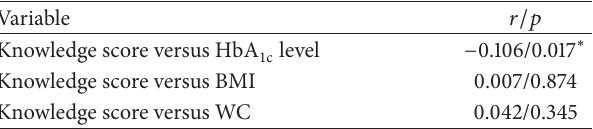
Table 3: Correlation between diabetes knowledge score and prac- tices among patients ( 𝑛 = 500